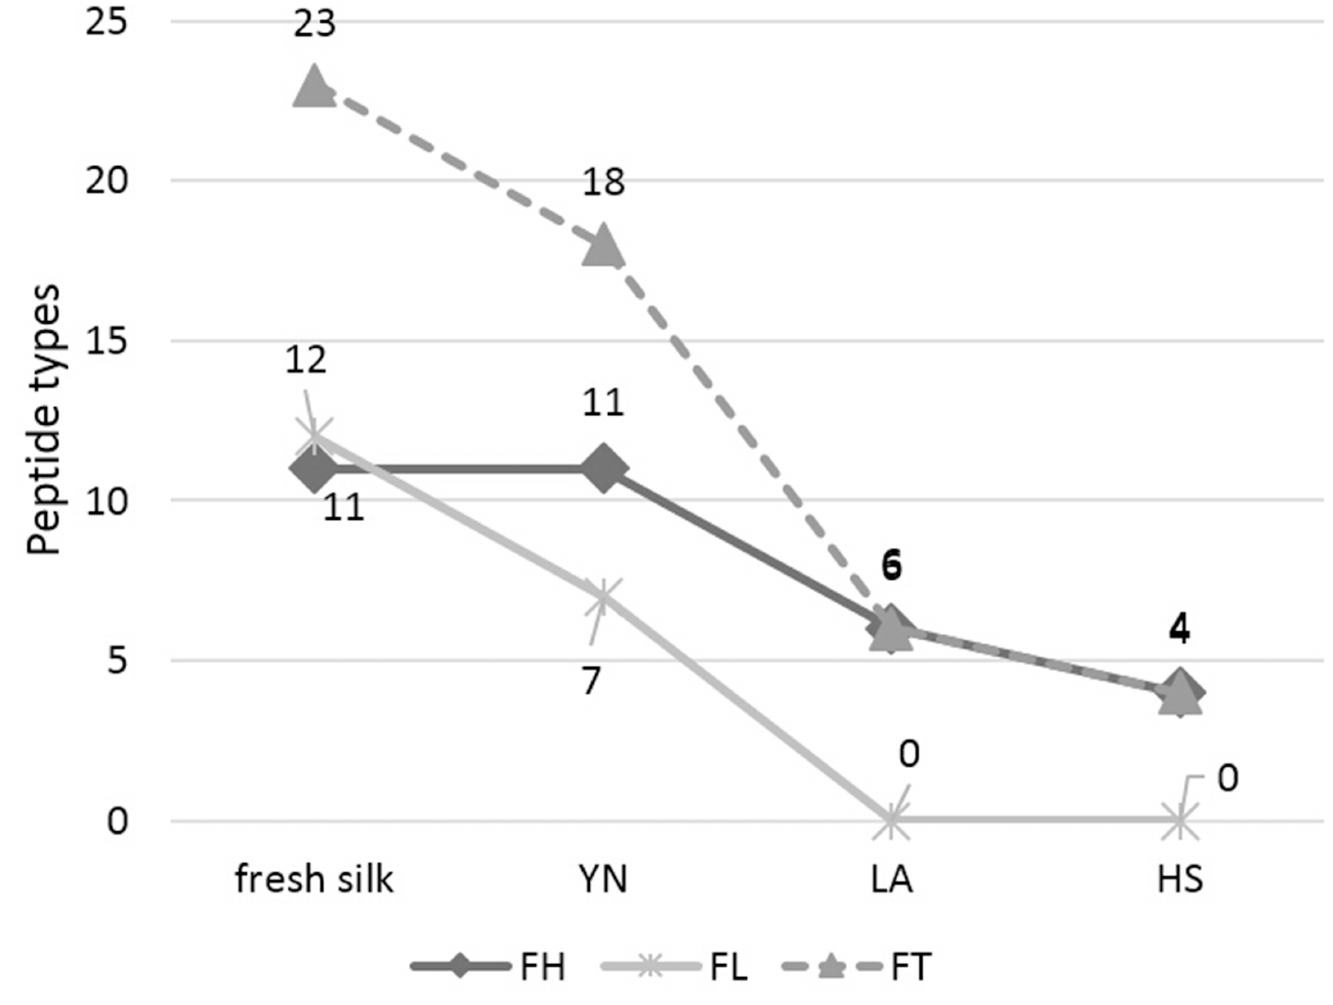
Fig 2. The tendency of detected amount of peptide